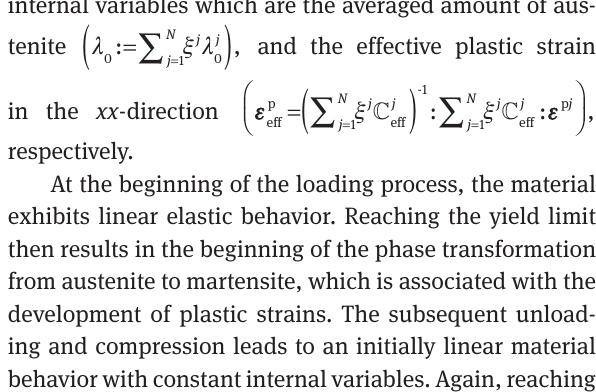
Figure 5: Development of the effective plastic strain in the tensile